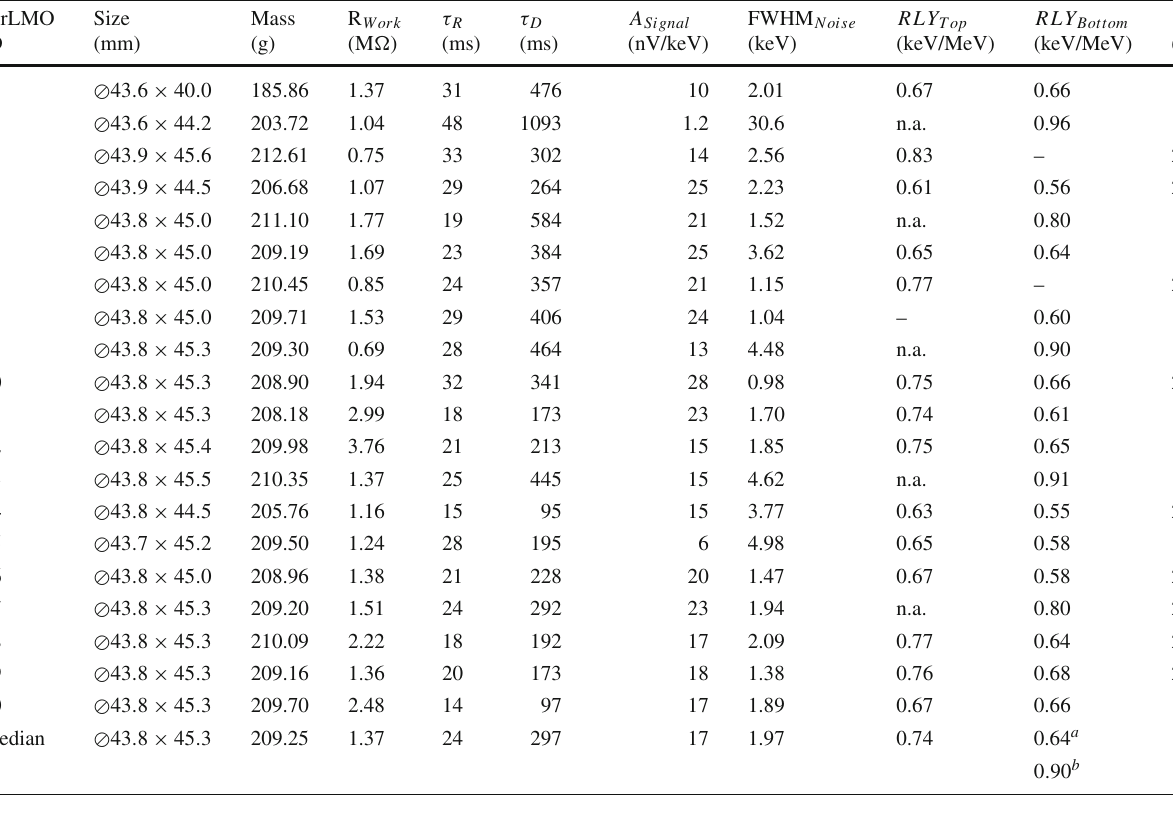
Table 3 Performance of 100 Mo-enriched Li 2 MoO 4 bolometers of the CUPID-Mo experiment operated at 20.7mK in the EDELWEISS set- up at LSM (France). This table contains the following information: the crystal size and mass, the NTD resistance at the working point (R Work ), the rise-time ( τ R ), the decay-time ( τ D ), the voltage sensitivity ( A Signal ), the baseline noise resolution (FWHM Noise ), the scintilla-